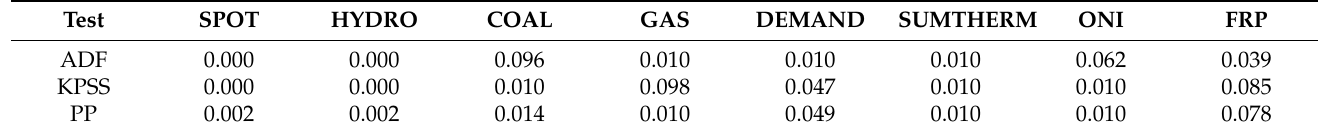
Table 2. ADF, KPPS, PP seasonality tests results in p -values contrasted at a significance level of 5%. Test SPOT